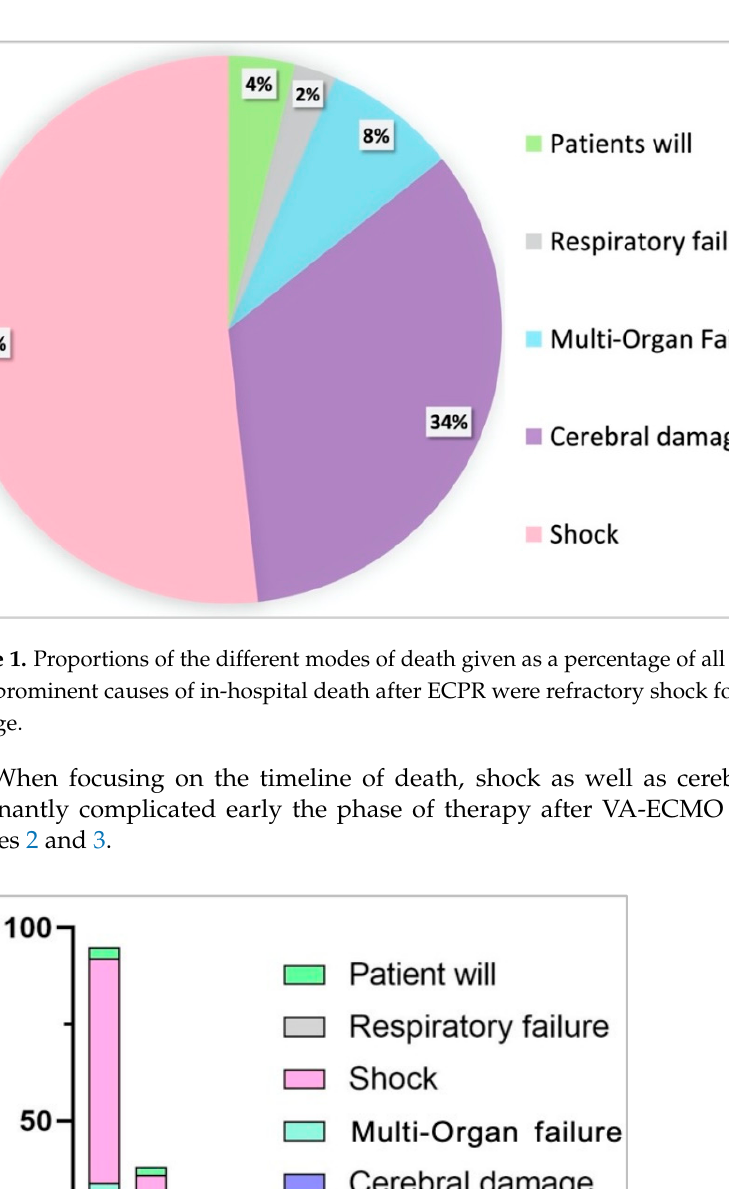
0.6565 Data given in mean ± standard deviation or number of patients (percentage). p-values are calcu- lated between survivors and non-survivors. (significance level p-value < 0.05). Abbreviations: NSE—Neuron Specific Enolase. A total of 203 patients died during the hospital stay. Many patients died early after cannulation for VA-ECMO, specifically 95/203 (46.8%) within the first two and 133/203